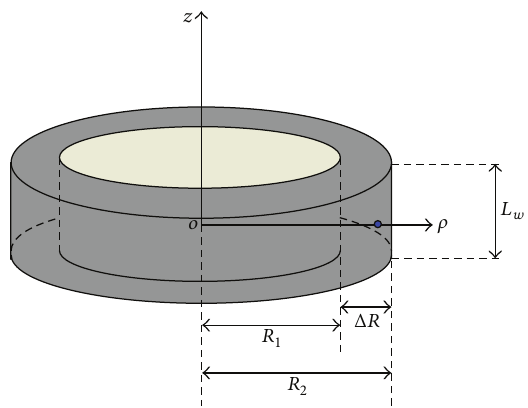
Figure 1: The diagram of a cylindrical wurtzite GaN/Al 𝑥 Ga 1−𝑥 N